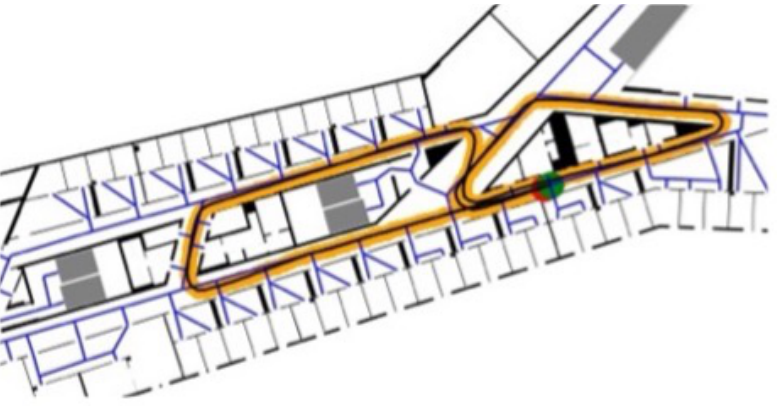
Figure 7. Ground truth points (orange) of the “eight path”; the red dot is the starting position and the green dot is the finish.